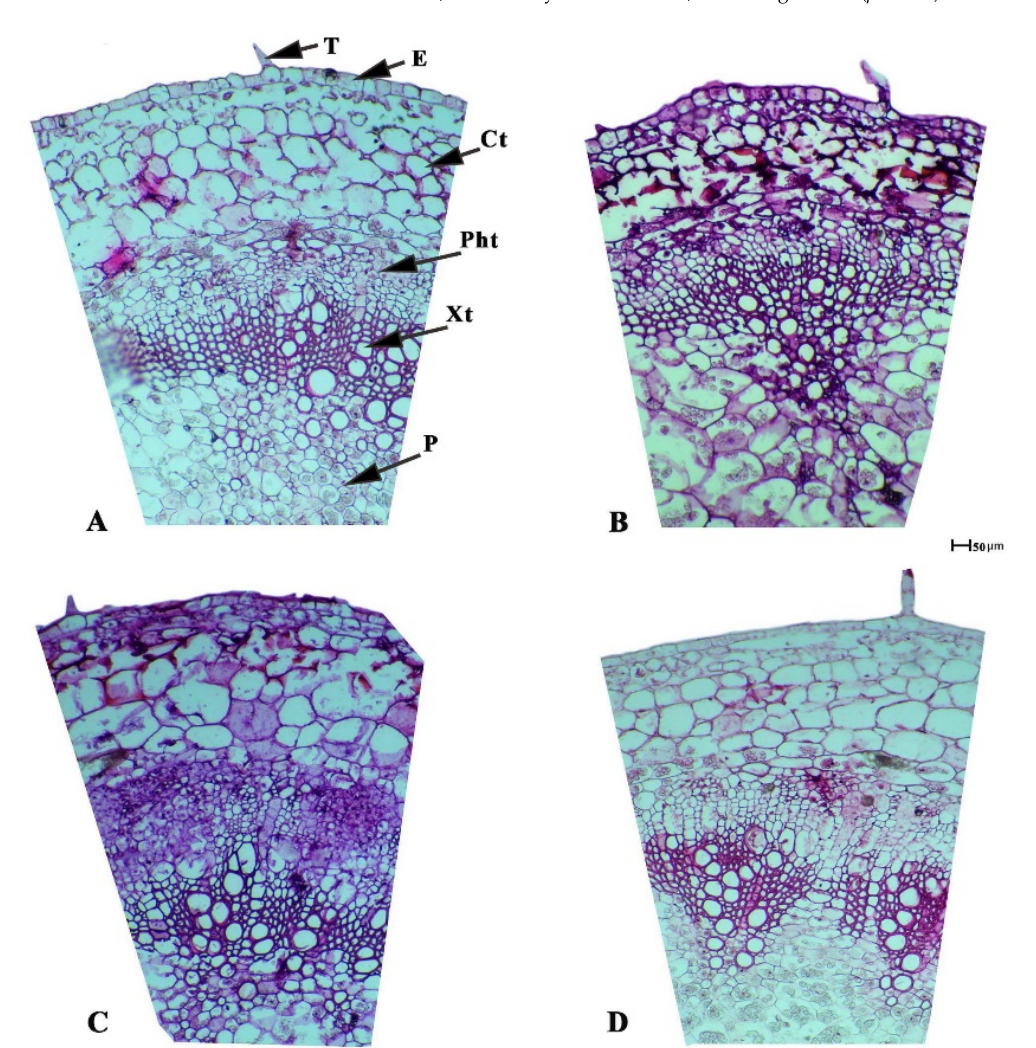
Figure 3. Transverse sections through the tomato stems, as affected by the application of various concentrations of PBZ substance, 10 days after applications, where ( A – D ) represent the treatments of the control, applied PBZ at 25, 50, and 100 mg L − 1 . The abbreviations: T (cuticle), E (epidermis), Ct (cortex tissue), Pht (phloem tissue), Xt (xylem tissue), P (pith), and MR (medullary rays).